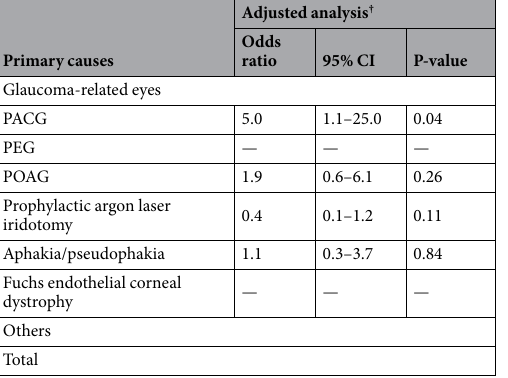
Table 3. Analysis of the association between iris damage and primary causes. CI: confidence interval, PACG: primary angle-closure glaucoma, PEG: pseudoexfoliation glaucoma, POAG: primary open-angle glaucoma. † Adjusting for age, combination of lens surgeries, previous corneal transplantation, past history of mild anterior uveitis and diabetes. We excluded PEG and Fuchs endothelial corneal dystrophy from adjusted analysis because there were a few patients with extensive iris